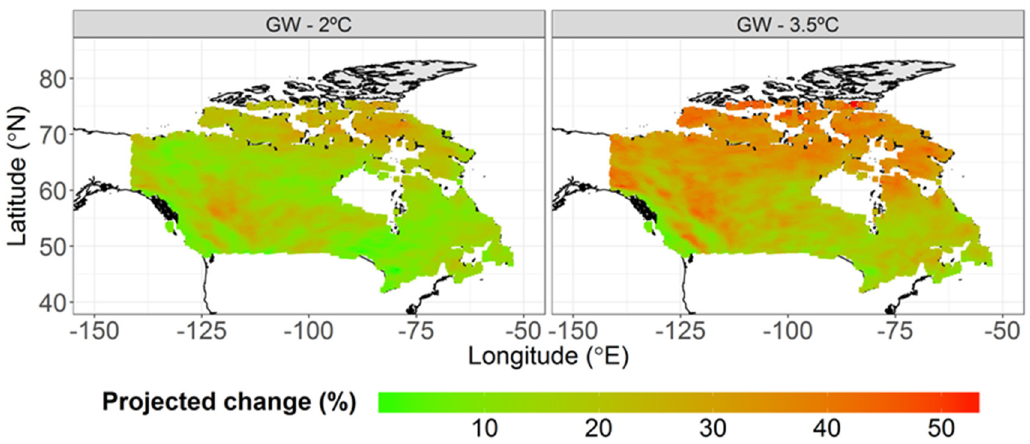
Figure 7. Projected percent changes in total precipitation across Canada under globally averaged warming of 2 °C and 3.5°.